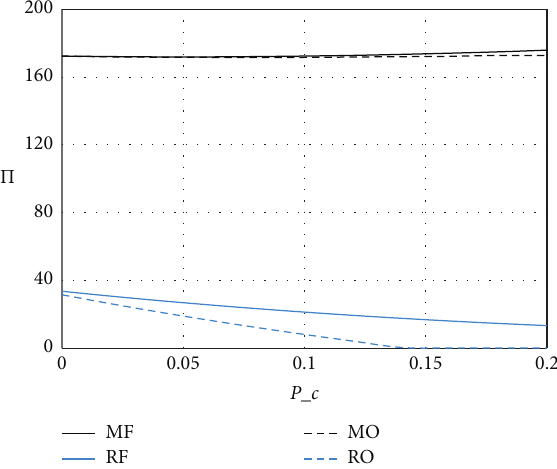
Figure 5: Impact of carbon price on profits in farsighted and myopic cases.